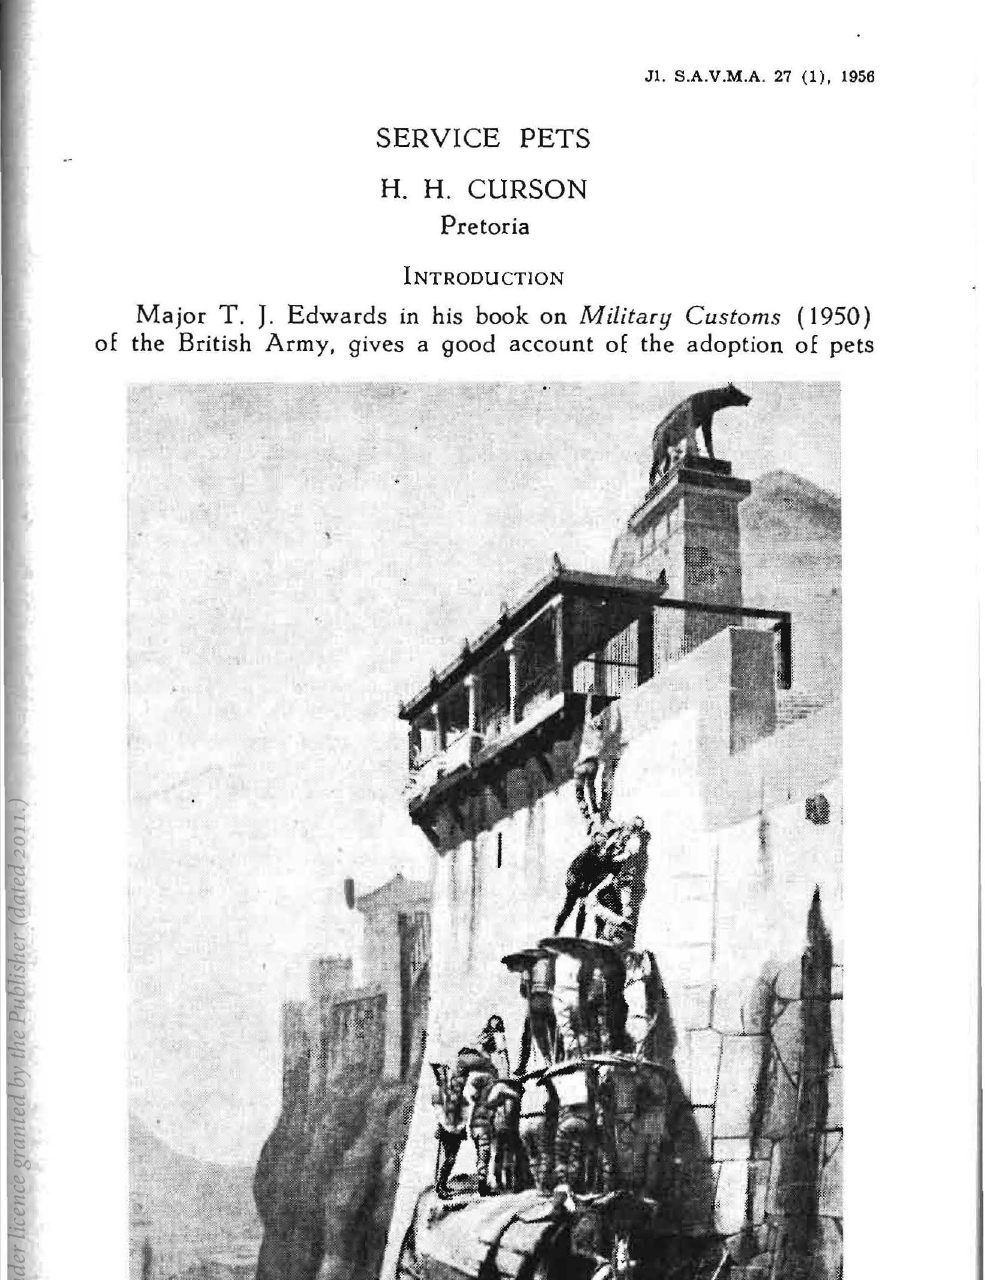
Fig. 1. From .. The New Book of Knowledge·' by Sir John